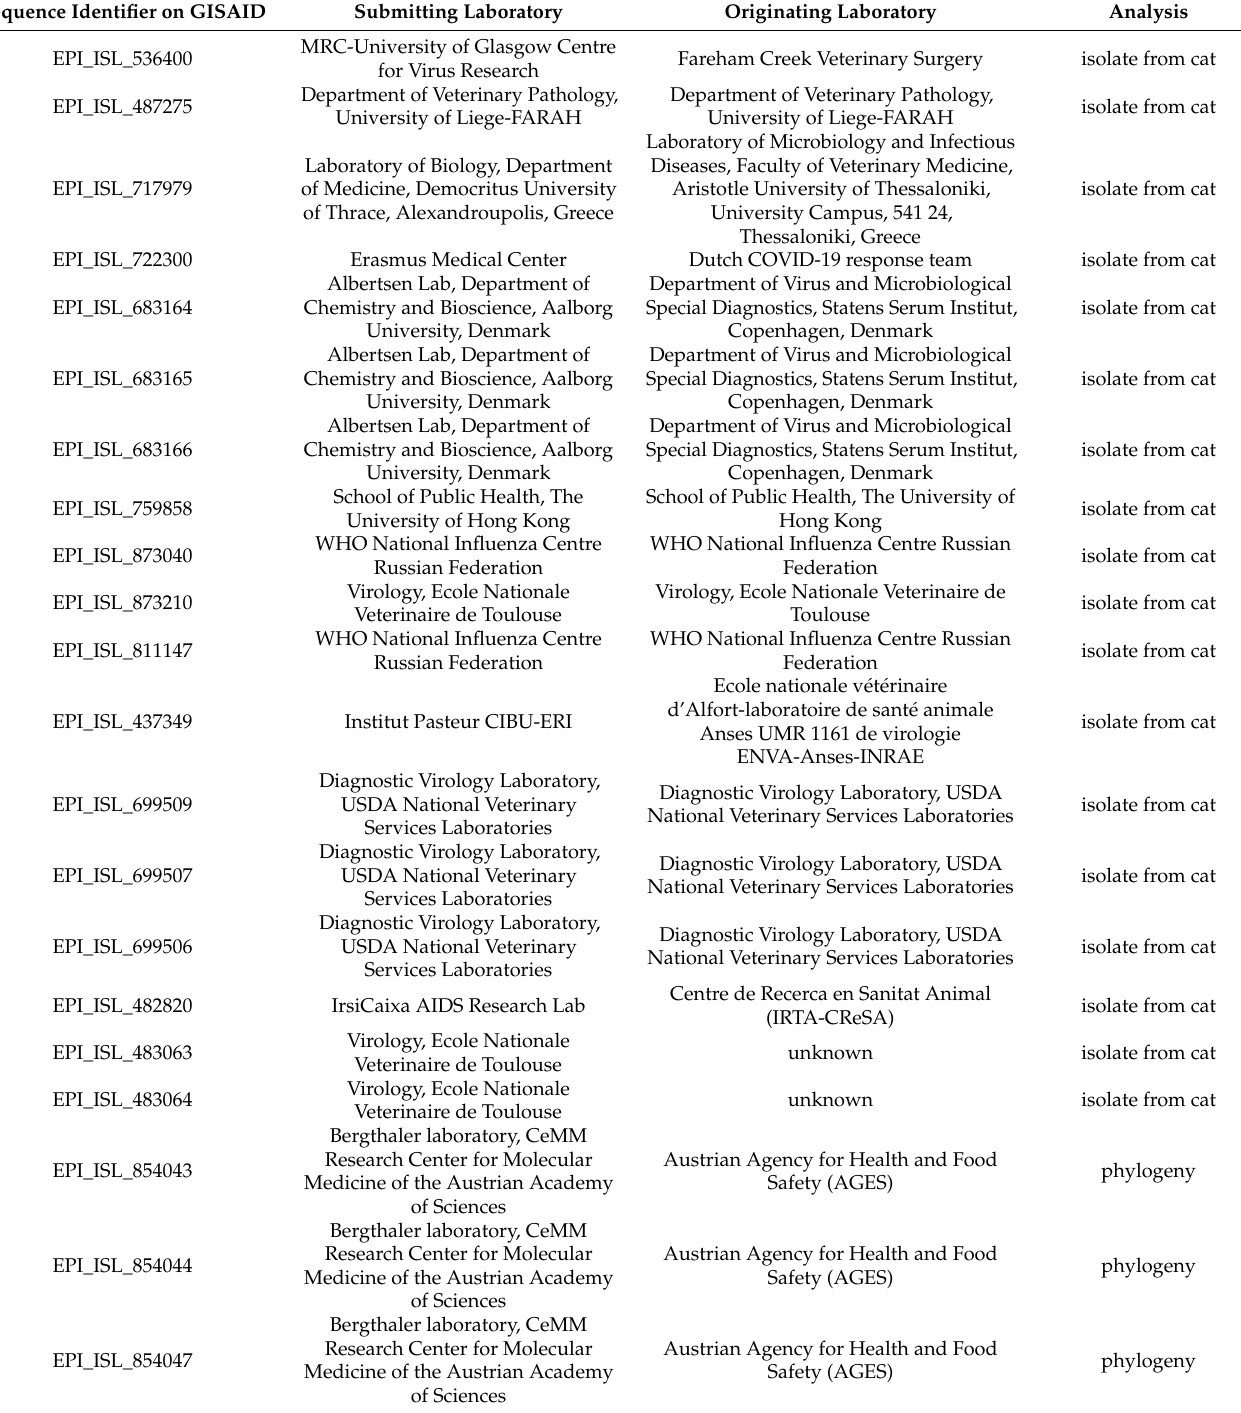
Table A1. Publicly available genome sequences from the Global Initiative on Sharing All Influenza Data (GISAID.org) used for bioinformatics analysis (26 January